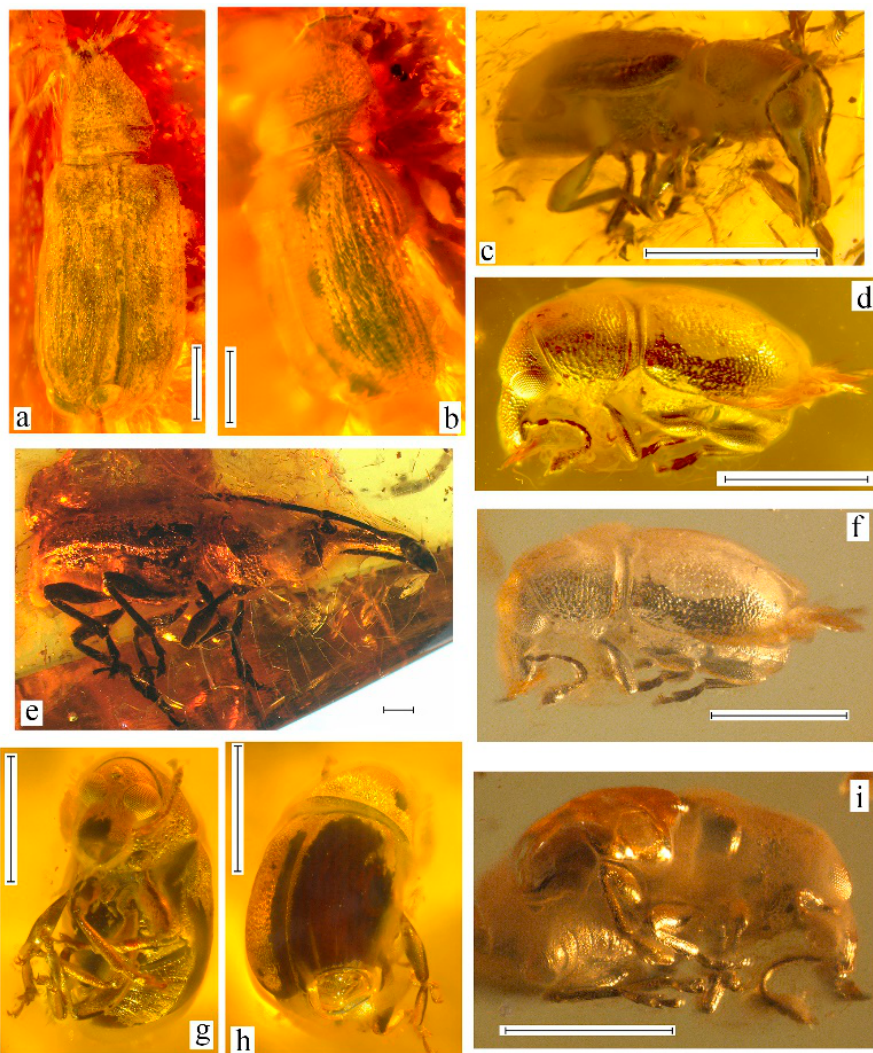
Figure 1. Habitus of Anthribinae from Baltic amber. ( a , b ) Pseudomecocerus alekseevi gen. et sp. nov. , holotype, KRAM , no. 6328: body, dorsally ( a ); body, laterally ( b ). ( c ) Allandroides vossi , holotype, ISEA , no. BA2012 / 11, body, laterally. ( d , f , i ) Glaesotropis balticus sp. nov. , holotype, FEH , no. 656: body, dorso-laterally ( d ); body, laterally ( f ); body, latero-ventrally ( i ). ( e ) Pseudomecorhis simulator , holotype, GPIH , no. 193, body, laterally; ( g , h ) G. martynovi , holotype, PIN , no. 964 / 1235: body, ventrally ( g ); body, dorsally ( h ). Scale bars: 1.0 mm. See Section 2 for names of collections.